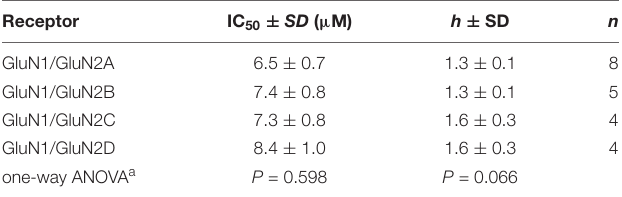
TABLE 4 | Inhibitory effect of compound 6 on GluN1/GluN2A-D receptors expressed in HEK293 cells and activated by 1 mM glutamate and 10 µ M